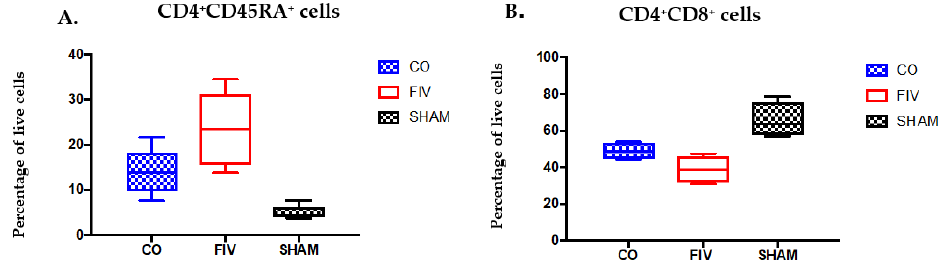
Figure 6. Thymic CD4 + CD45RA + cell percentages were trending lower in the CO compared to FIV cats ( P = 0.059), and both the FIV ( P <0.0001) and CO cats ( P = 0.0014) had higher CD4 + CD45RA + live cell percentages than the SHAM cats at 4 weeks FIV PI ( A ). CD4 + CD8 + double positive cell percentages